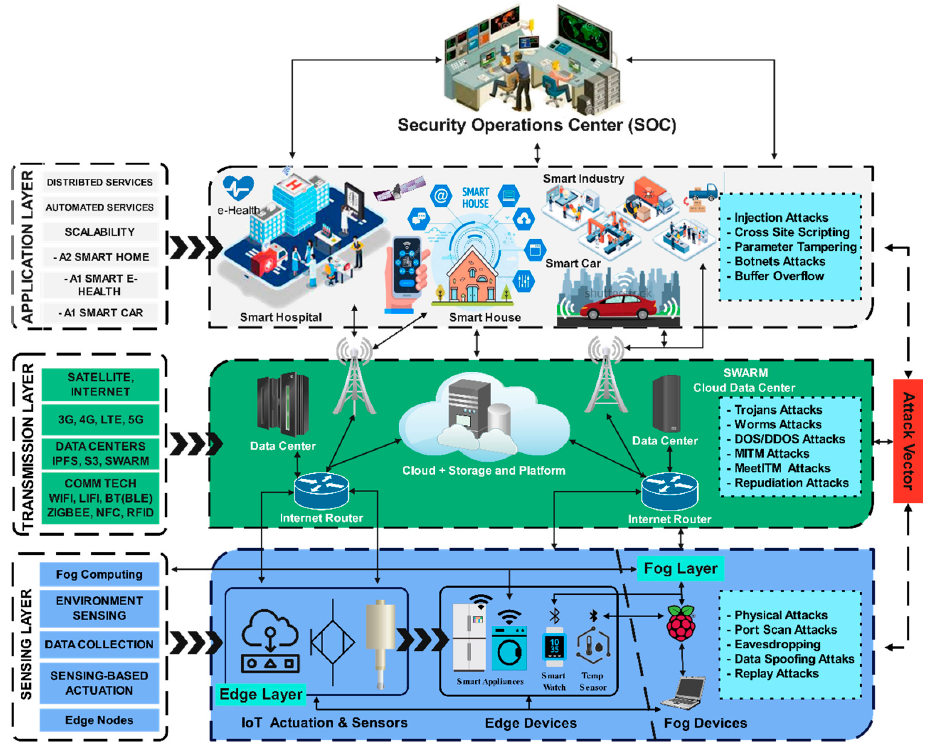
Figure 3. Generalized Smart City Layered Architecture.